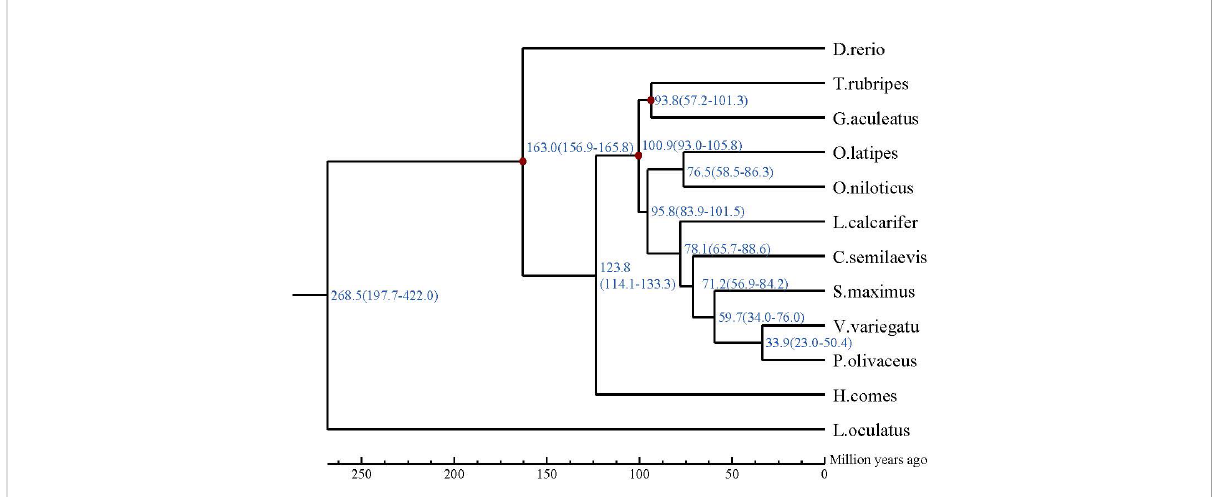
FIGURE 5 The phylogenetic relationship of Verasper variegatus with other 12 fi sh species. The divergence time was estimated using three fossil calibration points (red circles). The lower coordinate shows the estimated divergence time